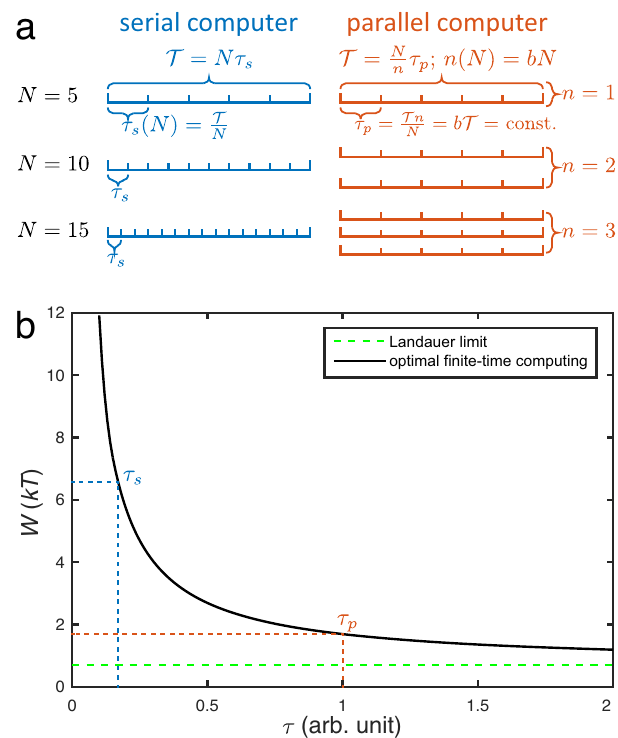
Fig. 1 | Assumptions for ideal serial and parallel computers. a Schematic illus- trationofthethreemainassumptions:(i)Thetotaltime T availabletosolveagiven problemrequiring N irreversiblecomputingoperationsislimited;(ii)anidealserial computer (left, blue) reduces the time per operation τ s with increasing problem size N ; (iii) an ideal parallel computer (right, red) is able to increase the number of processors n proportional to the size N in order to keep the time per operation τ p constant. b Optimal1/ τ behavioroftheenergyconsumptionofasinglealgorithmic operation of duration τ , and the effects that the serial (blue) or parallel (red) computing strategies have on the energetic cost of